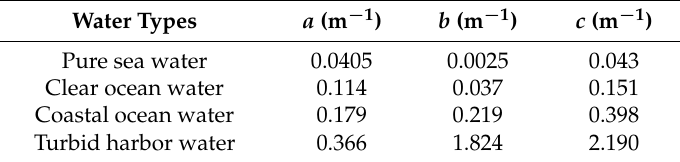
Table 1. Attenuation coefficients of four types of seawater at 520 nm